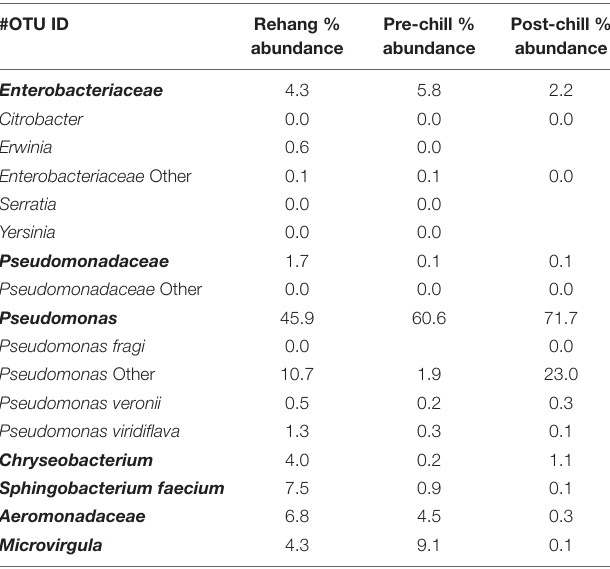
TABLE 4 | List of microorganisms present during all testing locations and abattoirs are in